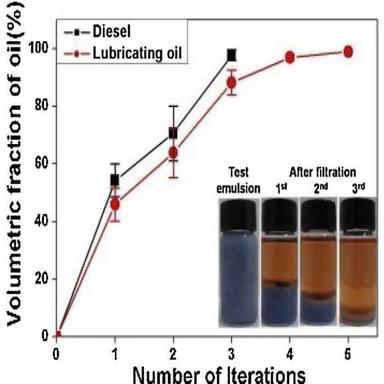
Volumetric separation of diesel and lubricant oil from water. Diesel was dyed red and water was dyed blue (For interpretation of the references to colour in this figure legend, the reader is referred to the web version of this article.).